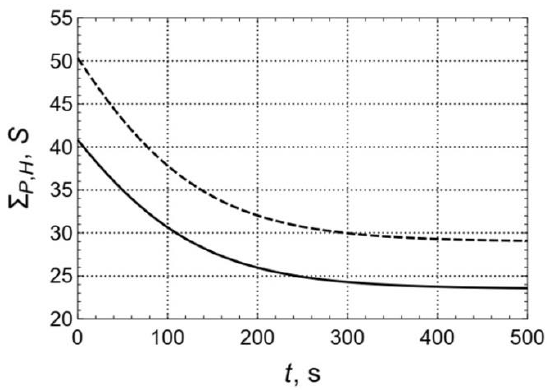
Figure 13. Time dependences of the perturbed integrated Pedersen (solid line) and Hall (dotted line) conductivities at the subsolar point (23.5° N, 90° E).